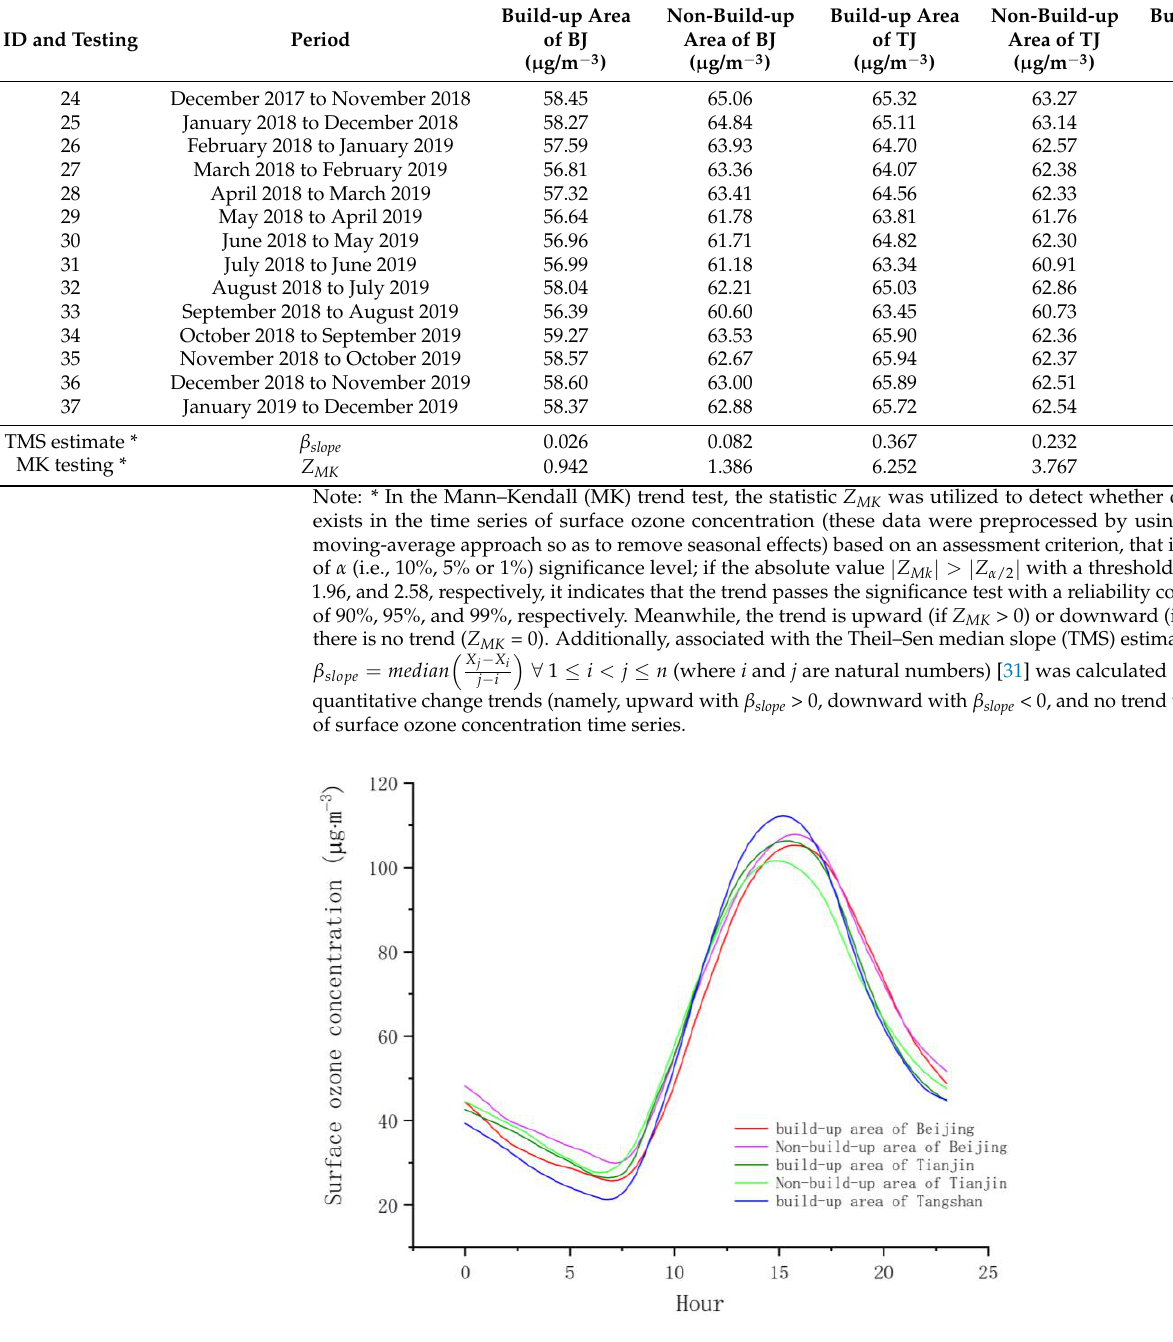
Figure 4. Diurnal variation curves of ozone concentration.